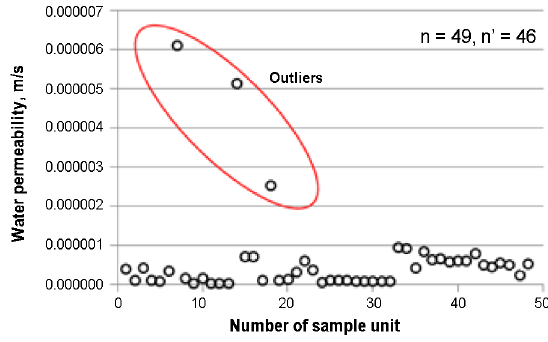
Fig. 9. A scatter diagram of ASB mixture of KG1 type water permeability with the